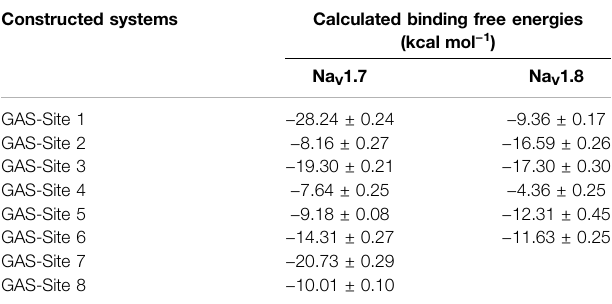
TABLE 3 | Calculated Δ G MM/GBSA values of GAS in Na V 1.7 and 1.8. Constructed